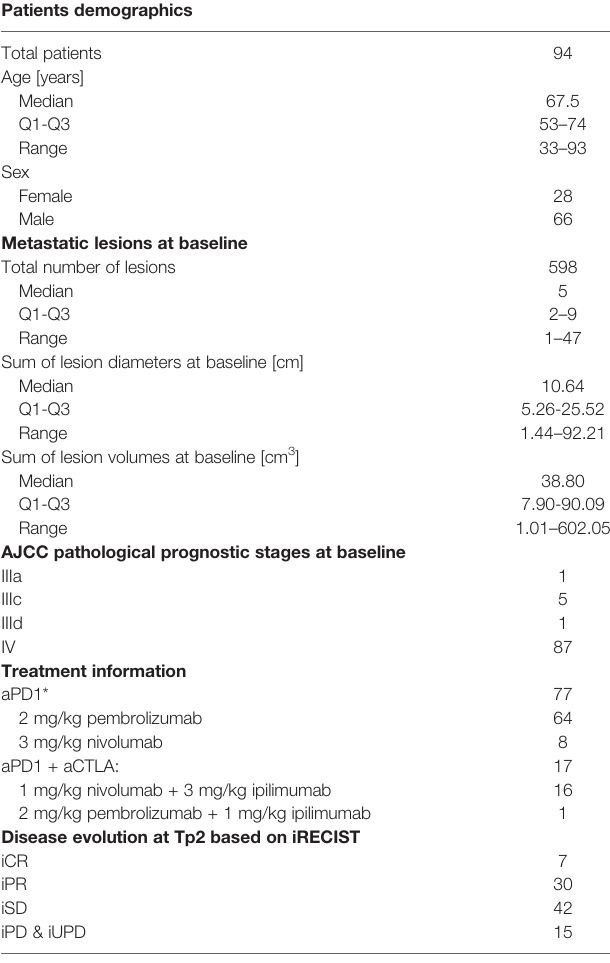
TABLE 1 | Patient and treatment